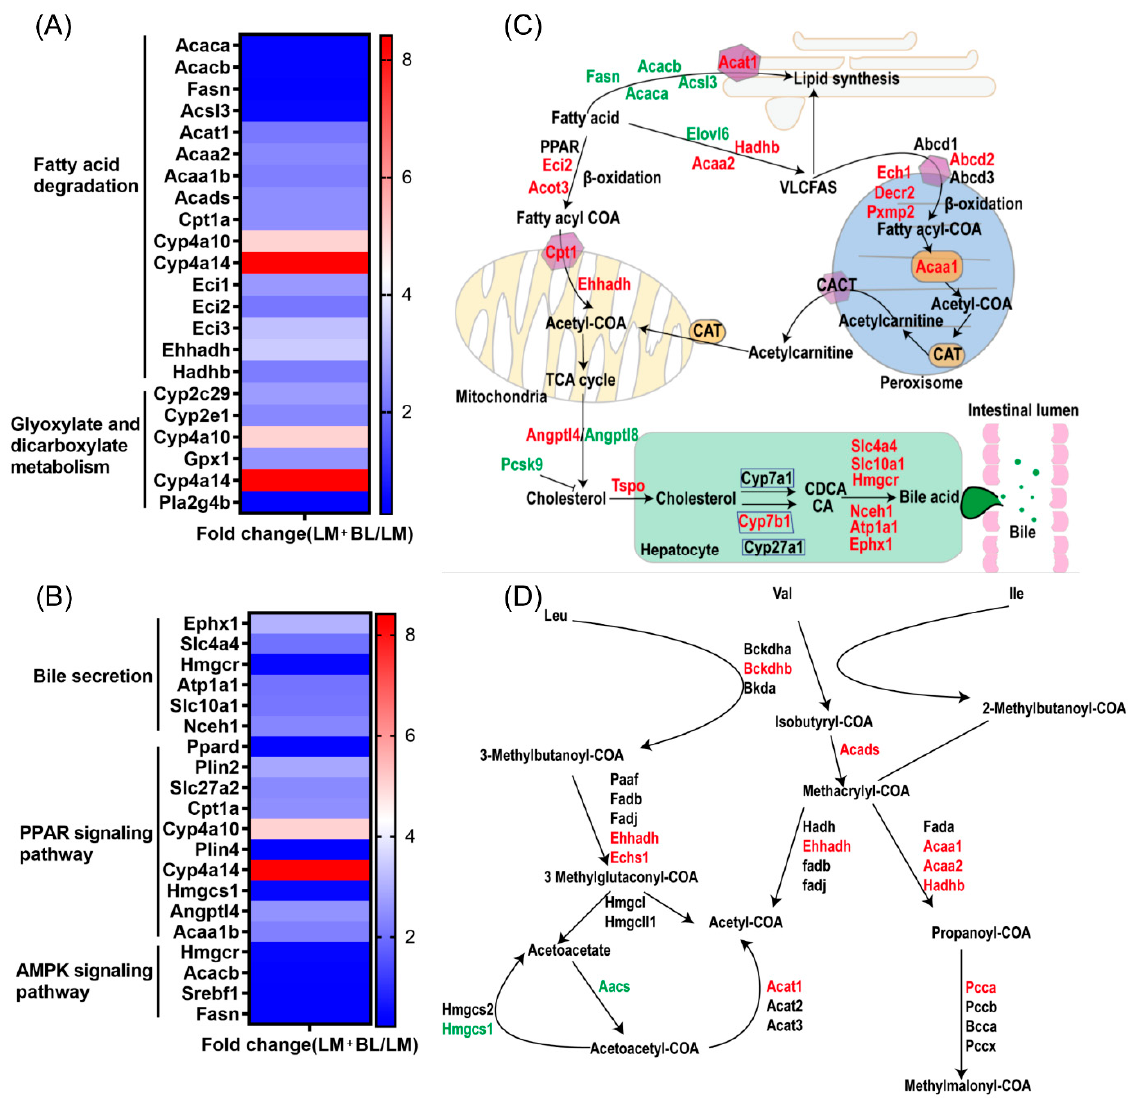
Figure 8. Transcriptomics revealed that baicalin regulates lipid metabolism and bile secretion. Fold change of differential expressed genes related to ( A ) fatty acid degradation and glyoxylate and dicarboxylate metabolism, and ( B ) bile secretion, PPAR signaling pathway, and AMPK signaling pathway. ( C ) The process of fatty acid degradation, peroxisome, fatty acid biosynthesis, and bile secretion. ( D ) The process of glyoxylate and dicarboxylate metabolism. The red words indicate upregulation and green words indicate downregulation.